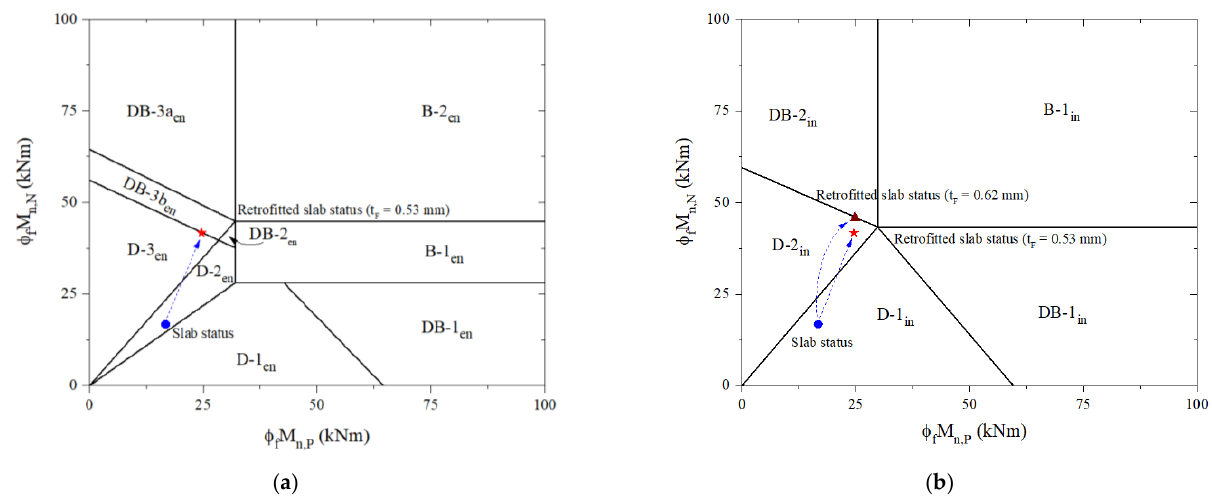
Figure 9. Predicting failure limits and failure mode considering brittle-failure prevention for the retrofitted slab: ( a ) the end span; ( b ) the interior